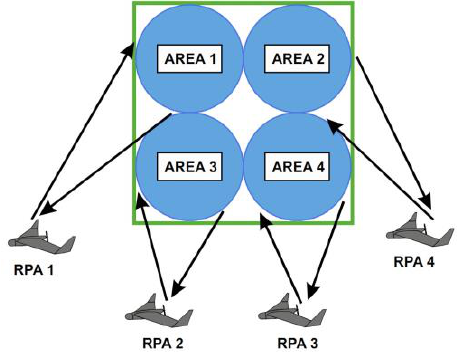
Fig. 1. A multi-RPA system for oil spill